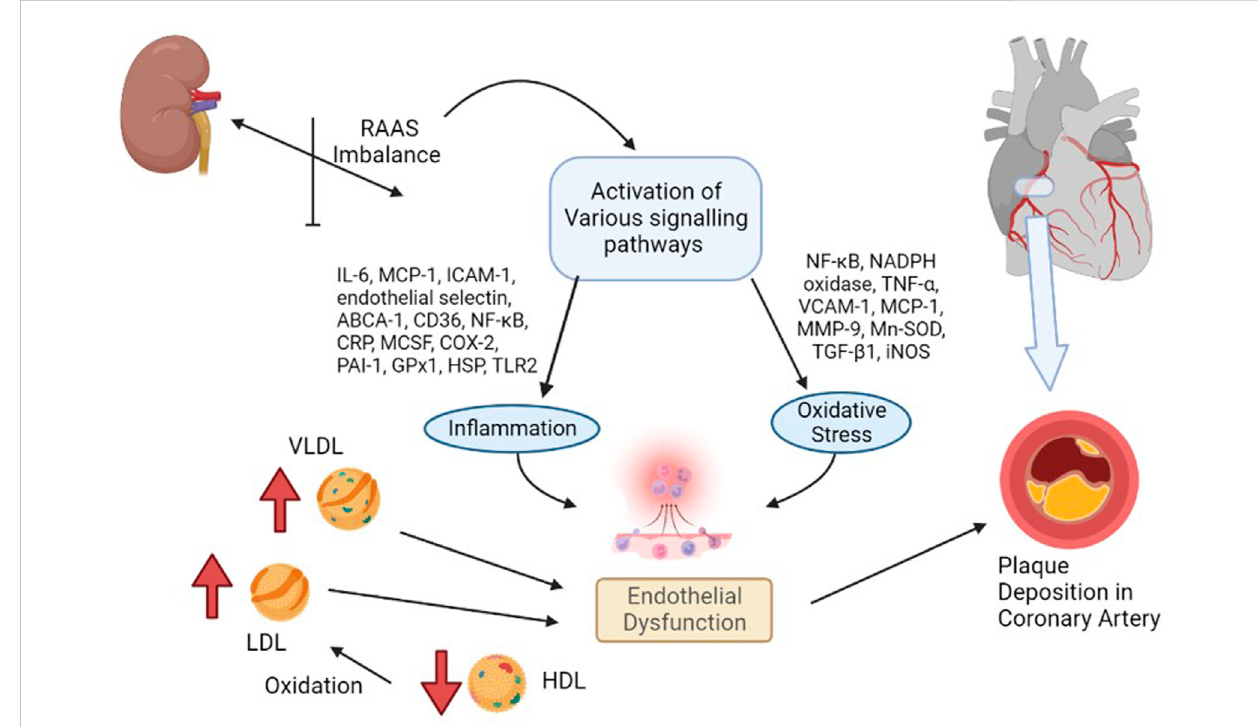
FIGURE 2 Renin – angiotensin system in the pathophysiology of coronary heart disease [overactivated renin – angiotensin system causes the activation of various harmful signaling pathways of in fl ammation and/or oxidative stress, or the harmful lipid molecules cause endothelial dysfunction, which exacerbates the process of coronary heart